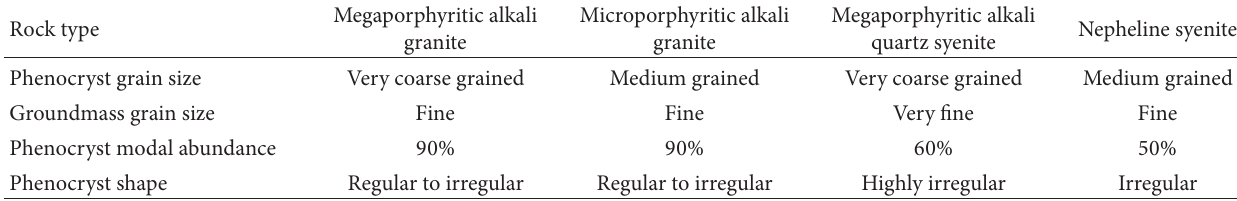
Table 3: Comparison of petrographic characteristics of the studied